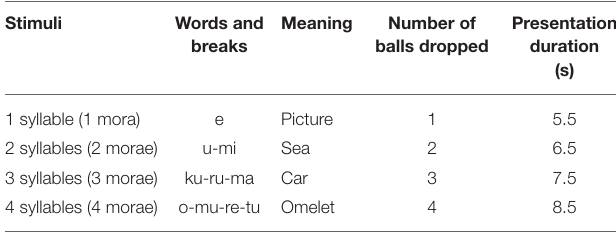
TABLE 2 | Stimuli in familiarization session. TABLE 3 | Presentation orders.